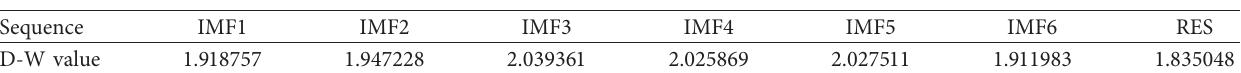
Figure 13: QQ test Table 2: D-W test value.